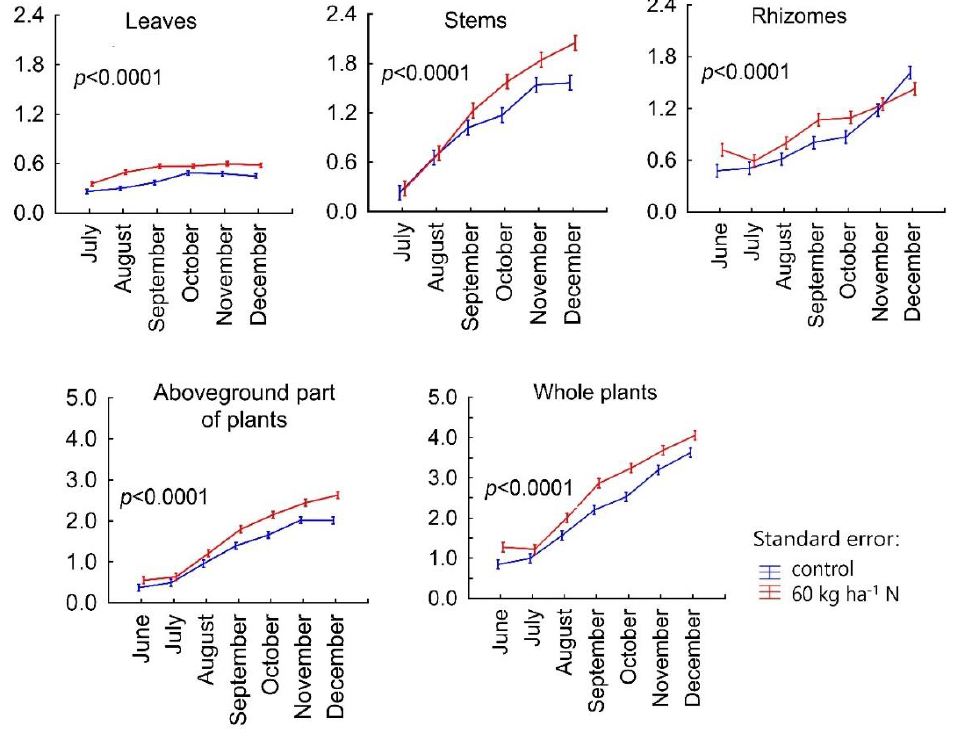
Figure 9. Sulphur uptake in examined part of miscanthus (g m − 2 ) (three-year average content from measurements during the growing season every 30 days).